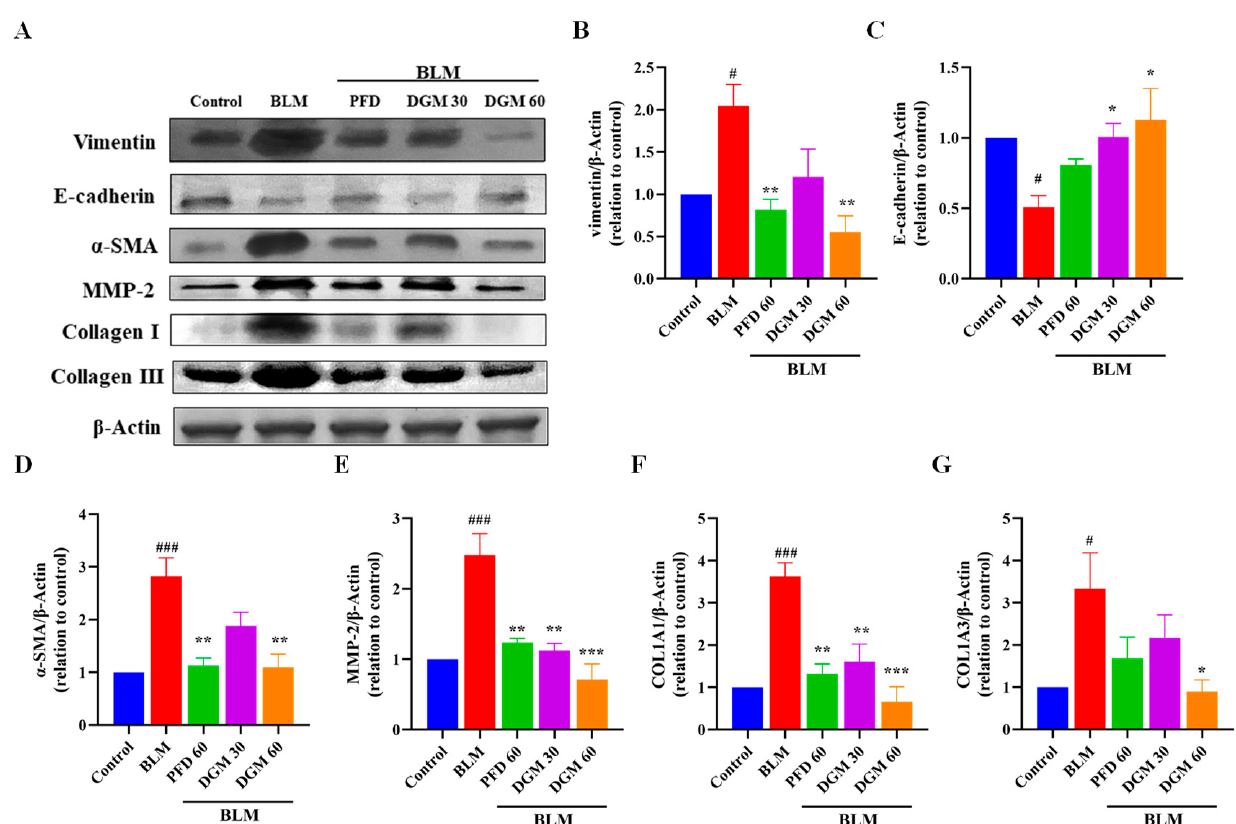
Figure 8. DGM repressed the bleomycin-induced EMT and fibroblast activation in rat lung tissue. ( A ) Western blotting analyses of vimentin, E-cadherin, α -SMA, MMP-2, Collagen I, and Collagen III protein expression in lung tissues. ( B ) Quantification of the vimentin/ β -actin ratio, ( C ) E-cadherin/ β - actin ratio, ( D ) α -SMA/ β -actin ratio, ( E ) MMP-2/ β -actin ratio, ( F ) Collagen I/ β -actin ratio, and ( G ) Collagen III/ β -actin ratio. Data represent the mean ± SEM ( n = 6). # p < 0.05, ### p < 0.001, vs. control group; * p < 0.05, ** p < 0.01, *** p < 0.001, vs. BLM group.